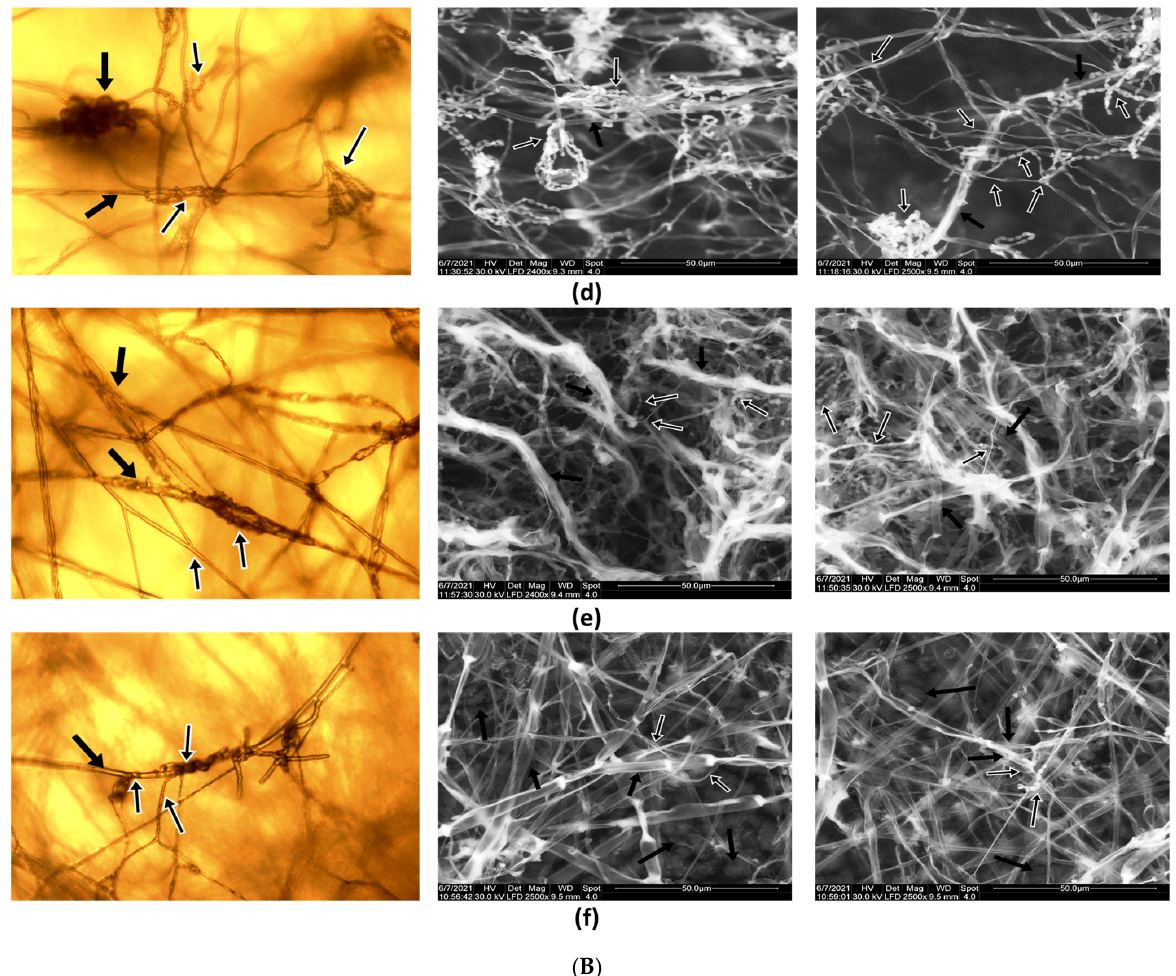
Figure 3. ( A ) Observations of the antagonism mechanism between Paecilomyces lilacinus 112 and plant pathogenic fungi under microscope light (left) and SEM (right). ( a ) Paecilomyces lilacinus versus Alternaria alternata : Paecilomyces presents ovoid conidia forming chains that can be intertangled (white arrow); septate and thin hyphae of Paecilomyces are coiled or attach upon Alternaria hyphae; septate and large hyphae of Alternaria (black arrow); acropetal chains of conidia (white arrow). ( b ) Paecilomyces lilacinus versus Cladosporium T2 isolate: Paecilomyces develops thin hyphae that are coiled around Cladosporium filaments (white arrow); Cladosporium large hyphae, conidiophores, and conidia in branched acropetal chains (black arrow). ( c ) Paecilomyces lilacinus versus Rhizoctonia solani : Paecilomyces thin hyphae coiled or attached onto R. solani hyphae (white arrow); Paecilomyces conid- iophores, phialides, and long chains of ovoid conidia. Deformation of R. solani hyphae caused by Paecilomyces activity; R. solani large hyphae (black arrow). ( B ) Observations of the antagonism mech- anism between Paecilomyces lilacinus 112 and pathogens under microscope light (left) and SEM (right). ( d ) Paecilomyces lilacinus versu s Botrytis allii : B. allii presents large hyphae and conidia (black arrow). Paecilomyces thin hyphae are coiled or attached on the B. allii hyphae; conidiophores, phi- alides, and long chains of ovoid conidia (white arrow). Deformation of pathogen hyphae caused by Paecilomyces activity. ( e ) Paecilomyces lilacinus sp. versus Fusarium graminearum : Thin hyphae and long chains of ovoid conidia from Paecilomyces (white arrow). Large hyphae of F. graminearum (black arrow). ( f ) Paecilomyces lilacinus versus Sclerotinia sclerotiorum : Large hyphae and mature melanized sclerotia of S. sclerotiorum (black arrow). Paecilomyces hyphae coiled or attached on S. sclerotiorum hyphae (white arrow); chains of ovoid conidia. Deformation of S. sclerotiorum hyphae caused by Paecilomyces activity.